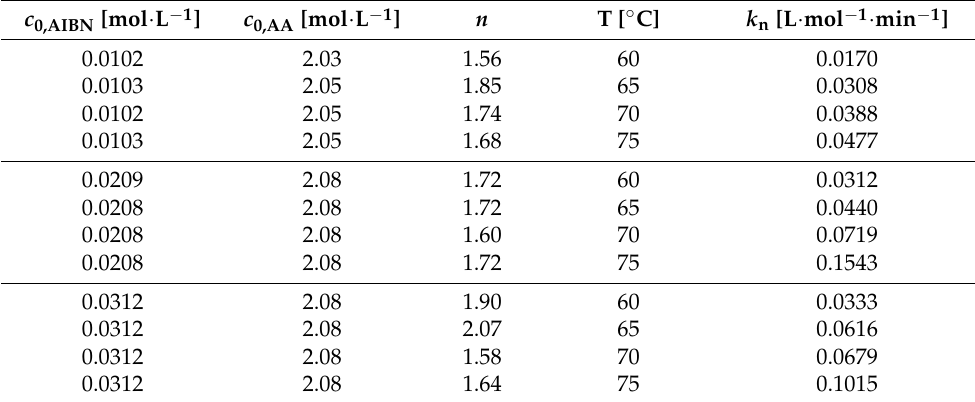
Table 1. Initial concentrations of acrylic acid (AA) and AIBN with their resulting reaction order and rate constants depending on the reaction temperature.